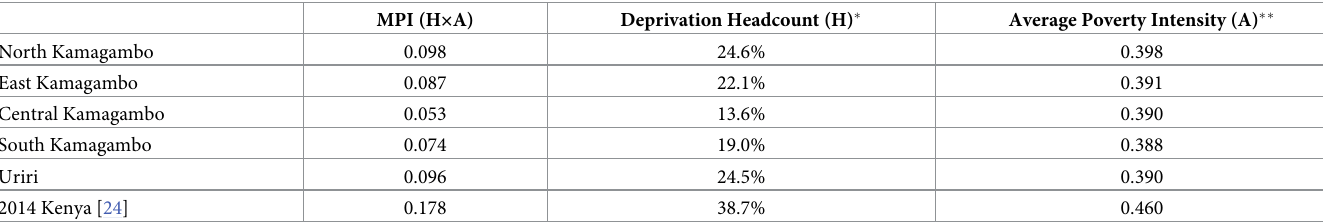
The domain areas of deprivation were generally similar across surveyed areas (Table 4). Notably, deprivation in sanitation facilities was much lower in North and East Kamagambo than in other areas. Central Kamagambo had lower rates of deprivation in drinking water, electricity, and housing than other areas. Rates of deprivation in living standards dimensions were generally higher than in education and health dimensions. Poverty and depression Of the 3,939 participants for which depression data were available, 481 (12.2%) met the criteria for depression based on a PHQ-8 depression score � 10. In logistic regression stratified by region and adjusted for age, household size, marital status, and income source, for every one- Table 3. Multidimensional poverty